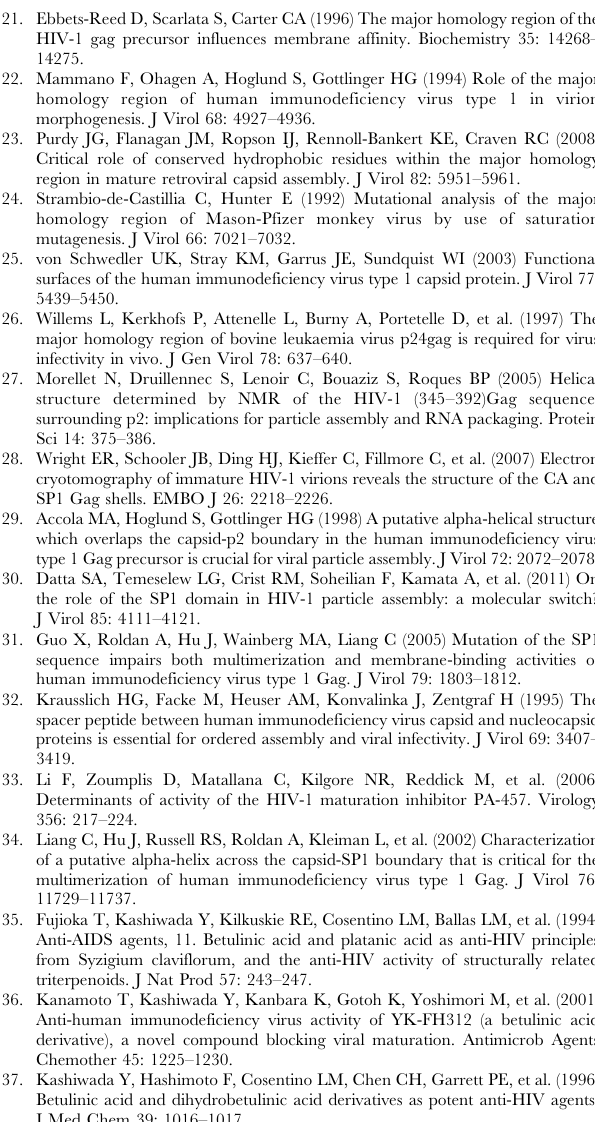
particles that contain both the electron-dense crescent and a condensed, conical core-like structure (blue arrow). Figure S2 Membrane binding analysis for CA-G156E and P157S mutants. 293T cells were transfected with WT or mutant PR-defective (pNL4-3/PR 2 ) molecular clones. Membrane flota- tion assays were performed as described in the Materials and Methods. Gag and GAPDH were detected by quantitative western blotting; bands were quantified by Imaging Lab software (Bio- Rad). WT and non-myristylated Gag (1GA) serve as positive and negative controls, respectively. P values: **, p , 0.01; *, p , 0.05. Dashed line indicates lack of statistical significance. N= 2–3.